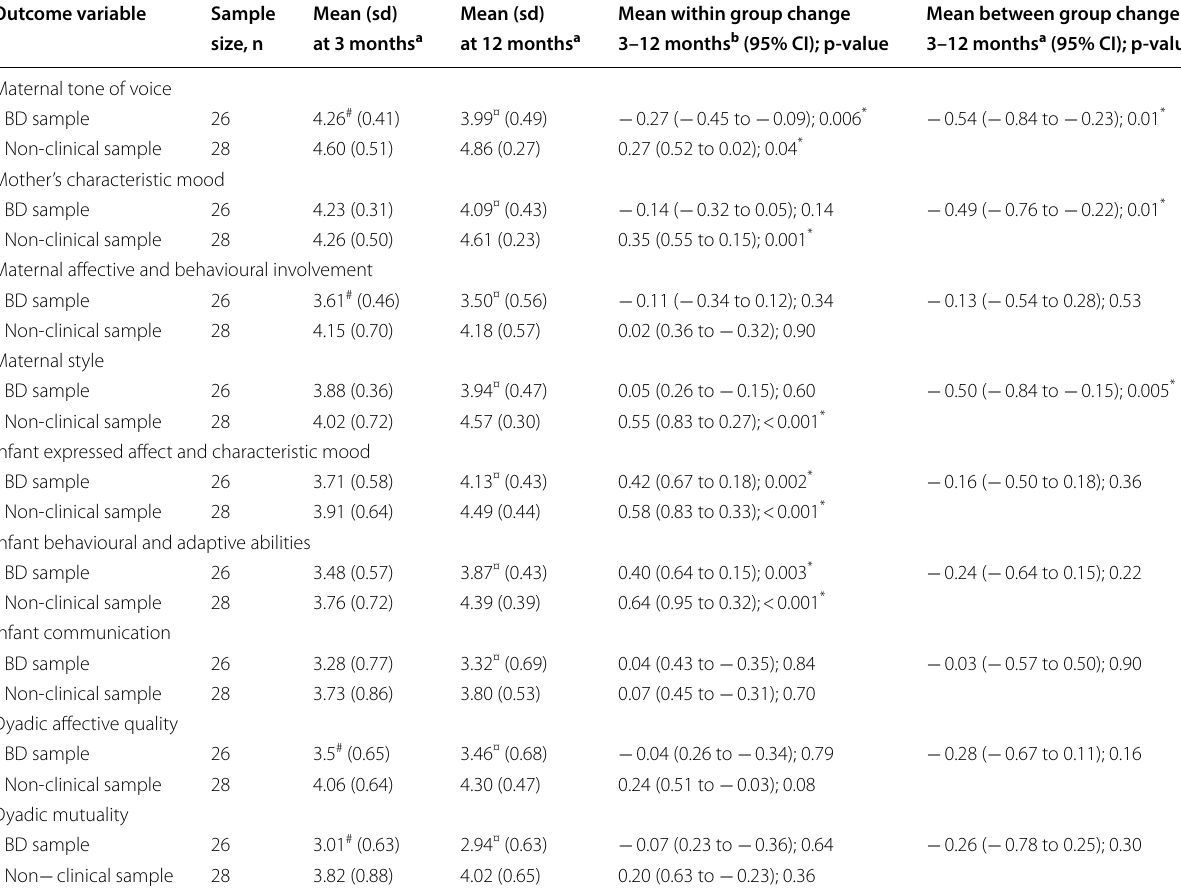
Table 3 Mean values on PCERA-clustered subscales at 3 and 12 months and within- and between-group changes in the BD and the non-clinical sample from 3 to 12